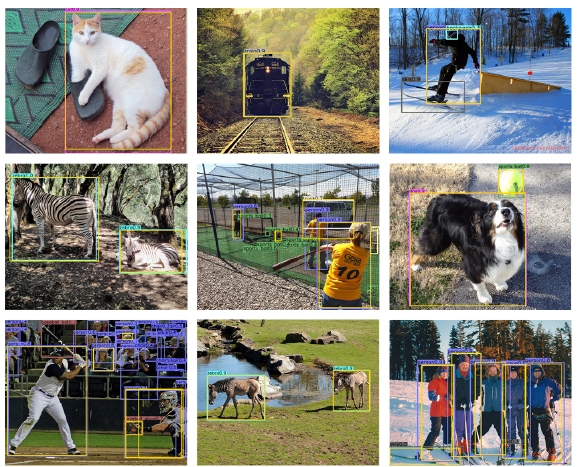
Figure 9. Some detection results of SCNet on the MS COCO test-dev set. The gold boxes indicate the detection results of the control